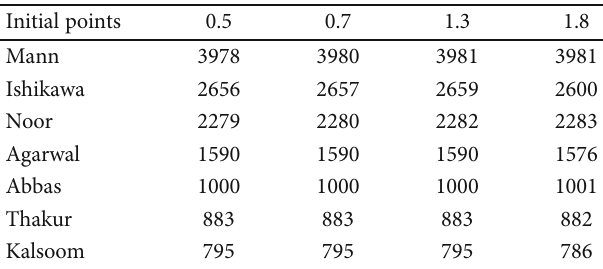
Table 1: Convergence behavior of Mann, Ishikawa, Noor, Agarwal, Abbas, Thakur, and Kalsoom et al. iterations towards fi xed